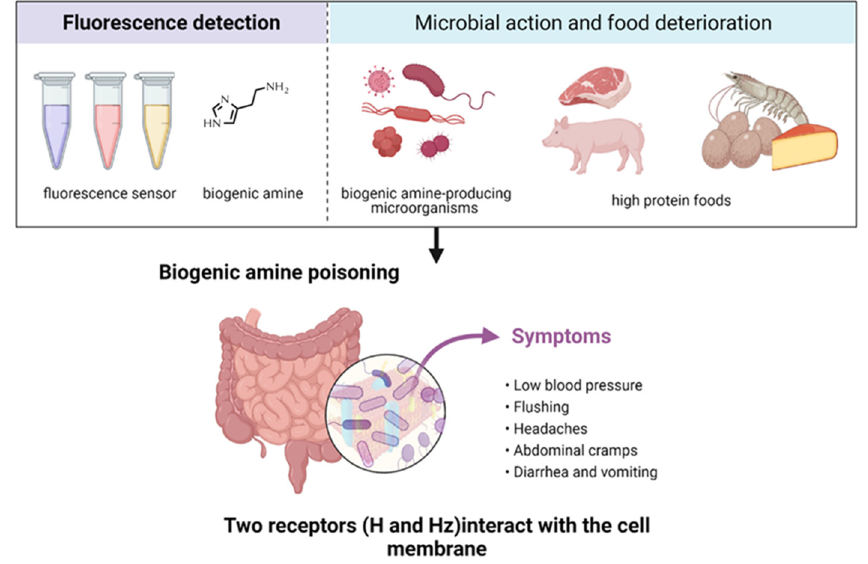
Scheme 1. Biogenic amine poisoning and fluorescence sensor detection of